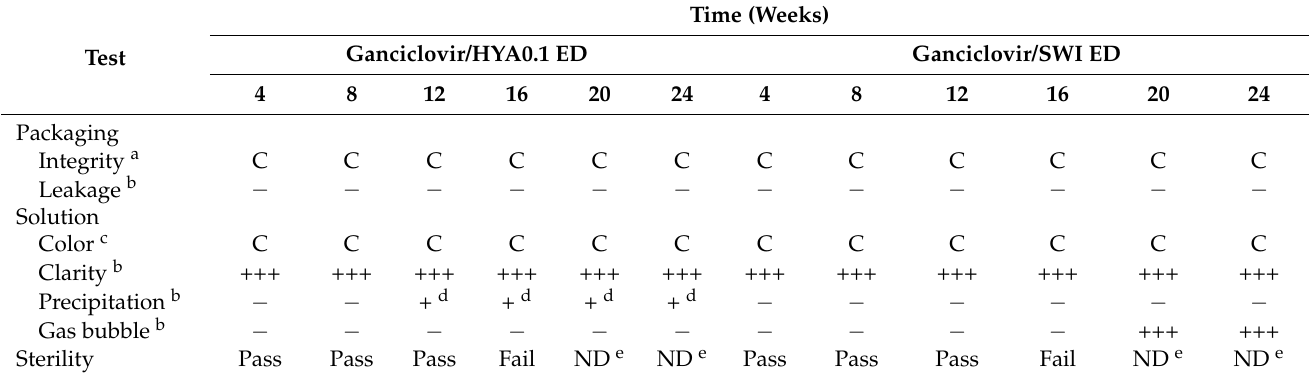
Table 5. Appearance and sterility results of ganciclovir/HYA0.1 ED and ganciclovir/SWI ED after storage at 5 ± 3 °C for 24 weeks.